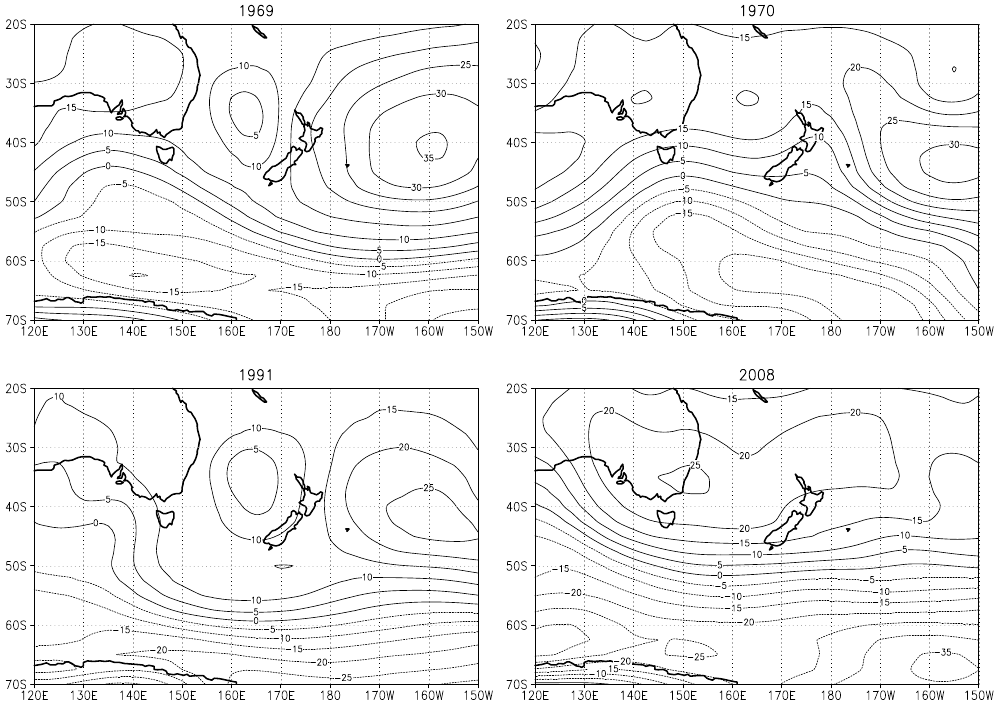
Figure 1. 1000hPa geopotential height fields for the top four September inflow events (9 September 1969, 17 September 1970, 13 Septem- ber 1991 and 24 September